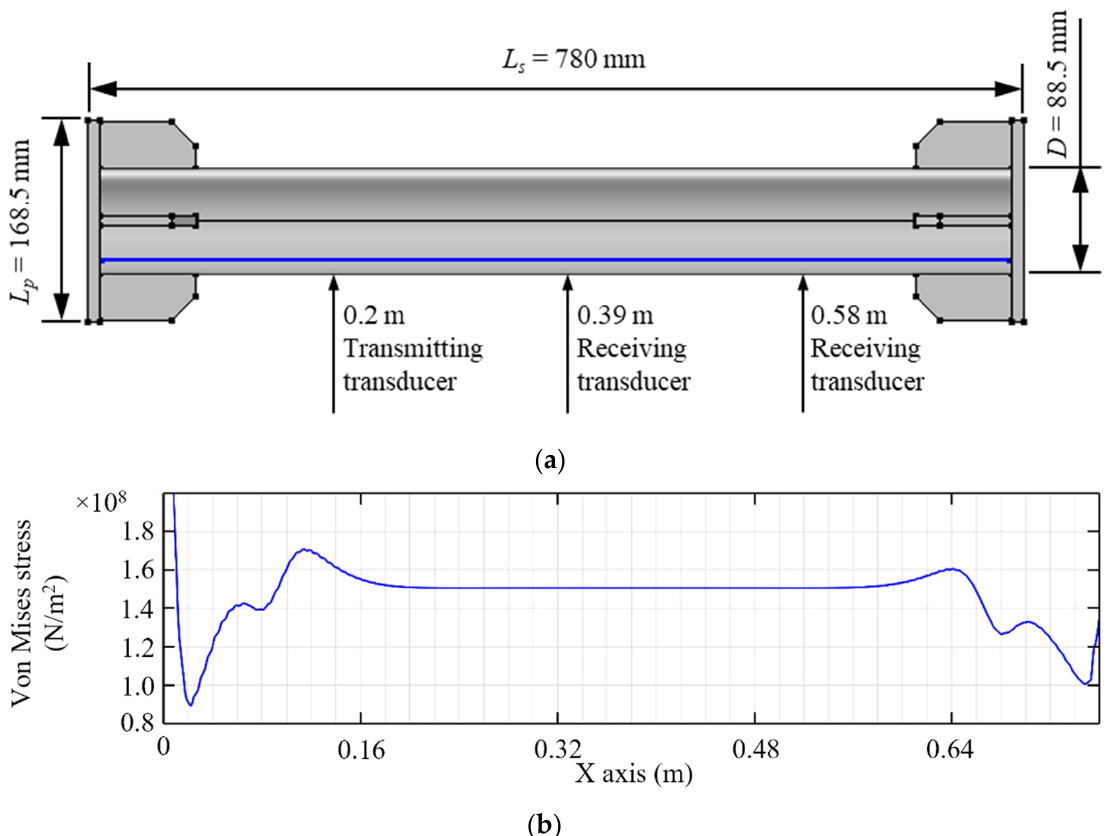
Figure 4. ( a ) Sizes of the specimen and ( b ) stress distribution in FE simulation. Table 1. Stress in each step of the loading